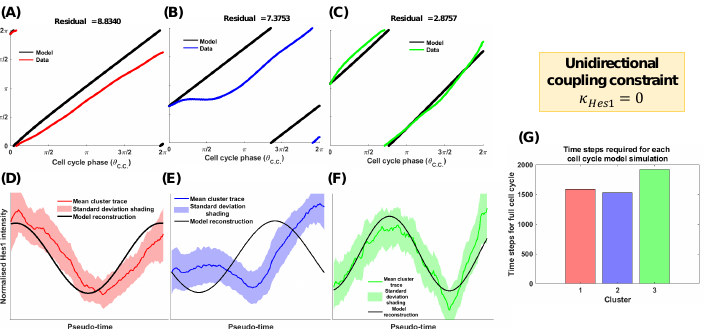
Figure A2. Results of the solutions to the model Equation (5) with the constraint κ Hes1 = 0 when ( i ) ( i ) θ is optimised to the data vector Θ , i = 1,2,3, frequency parameters are set as ω Hes1 = 24 − 1 Hes1 Hes1 ( i ) , i = 1, 2, 3 superimposed and ω C.C. = 27 − 1 . ( A – C ) Square torus diagram trajectories of solutions θ Hes1 over data trajectories from Figure 2B. ( D – F ) Psedo-time plots of rebuilt Hes1 dynamics found via (cid:17) (cid:16) ( i ) θ cos , i = 1,2,3 superimposed over mean traces from Figure 2A. In ( A – F ), the black lines Hes1 denote the model results, coloured lines denote the data (red: cluster 1, blue: cluster 2 and green: cluster 3), and in ( D – F ), the shaded areas denote the standard deviations of the data. ( G ) Bar chart of cell cycle duration predictions from the simulation for each cluster